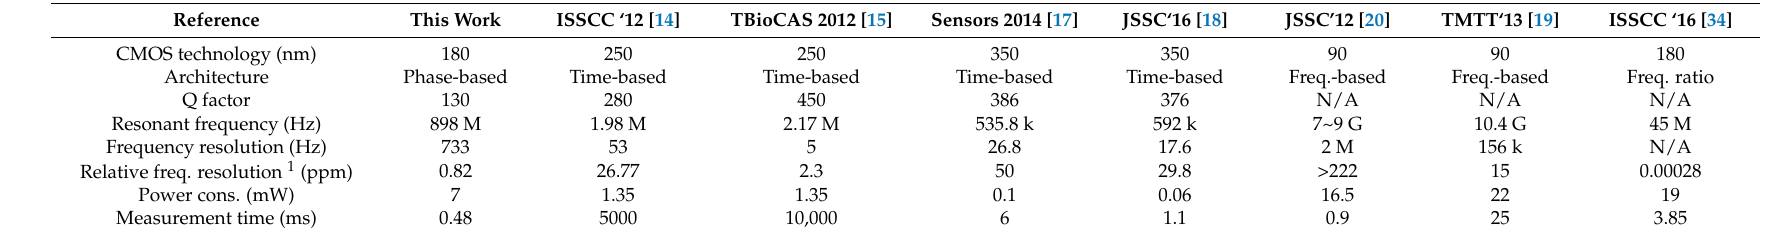
Table 1. Performance summary and